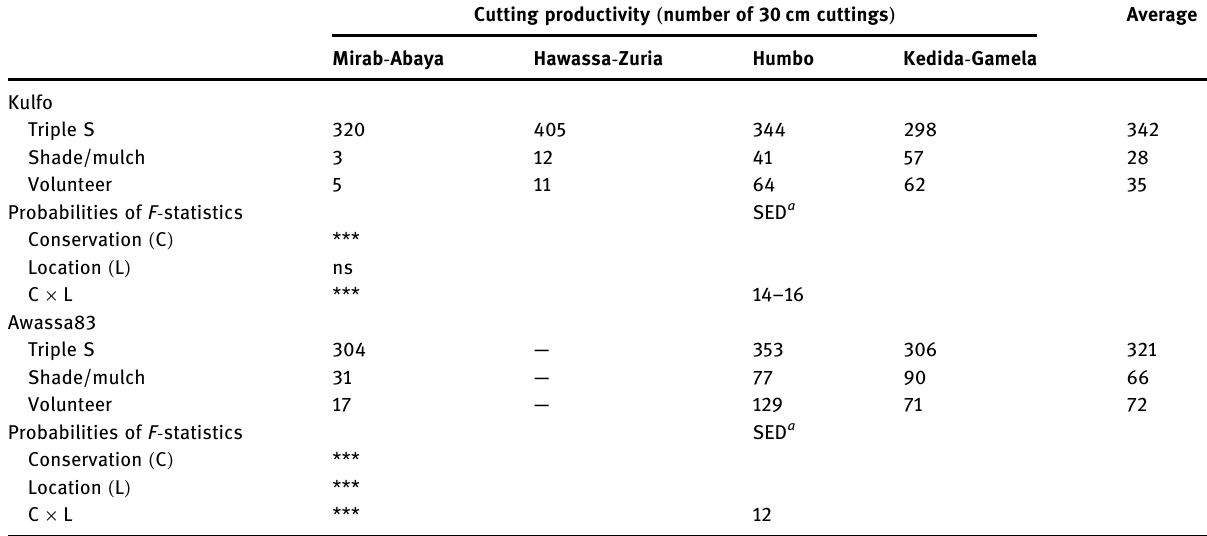
Table 2: E ff ect of conservation methods and locations on number of multiplied cuttings in dry areas of southern Ethiopia Cutting productivity ( number of 30 cm cuttings )